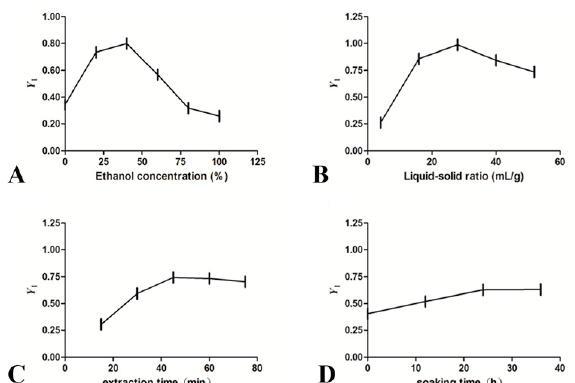
Figure 3. Effect of different extraction parameters ( A : ethanol concentration, %; B : liquid-solid ratio, mL/g; C : extraction time, min; D : soaking time, h) on Y 1 .